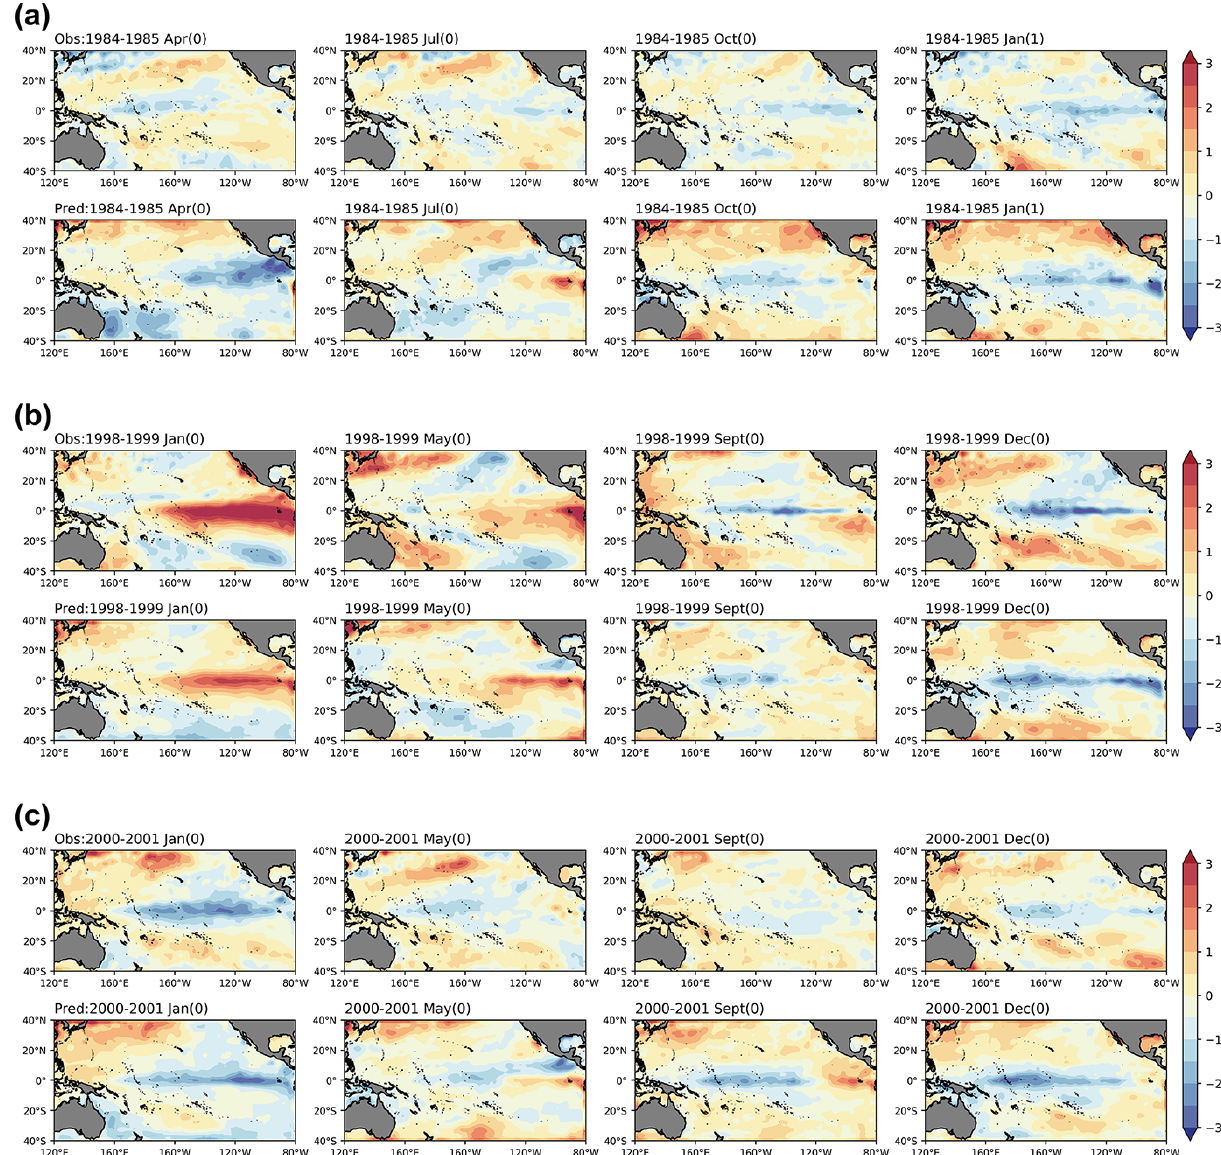
Figure 11. The same as in Fig. 9, but for the three CP El Niño events in (a) 1994–1995, (b) 2002–2003 and (c)